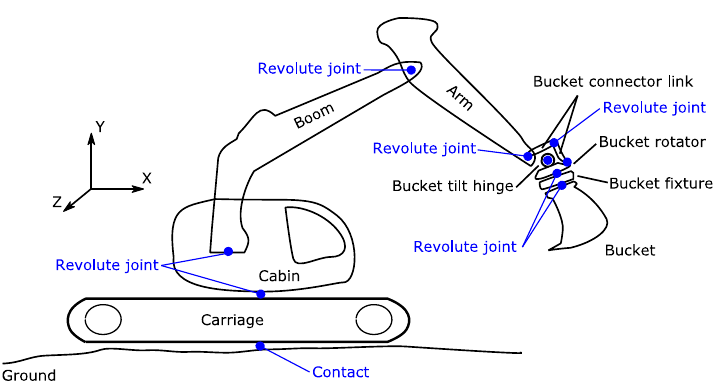
Figure 4. Topological schematic for the studied multibody model.